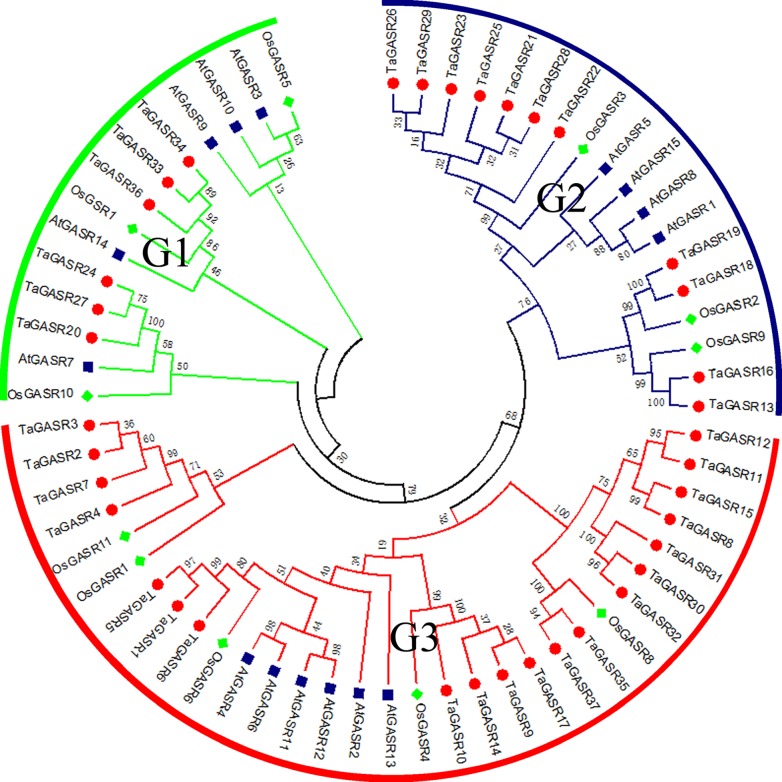
Phylogeny of GASRs from wheat, rice and Arabidopsis. The 37 TaGASR genes, 11 OsGASR genes, and 15 AtGASR genes are clustered into three subfamilies. Details of GASR genes from Arabidopsis and rice are listed in Table S6. The tree was generated using ClustalX version 2.11 using the neighbor-joining (NJ) method.